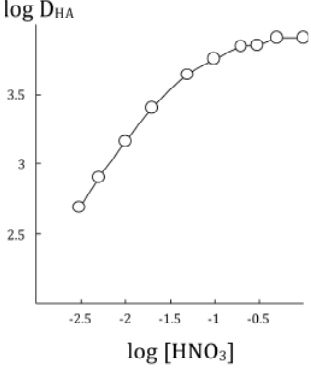
Figure 2 . The distribution of D2EHPA between the FB-D2EHPA sorbent and the aqueous 1M HNO represent error